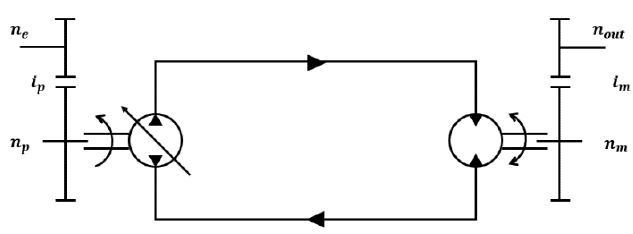
4 of 17 Figure 1. Schematic diagram of the prototype of hydro mechanical transmission (HMT). Table 1. Specifications of the engine and hydrostatic unit (HSU) of the HMT tractor prototype. Item